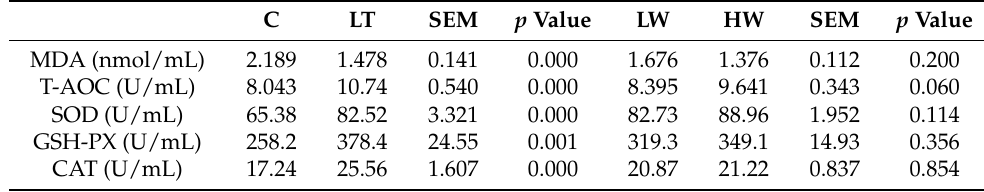
Table 3. Effects of cold stress on antioxidant indices in